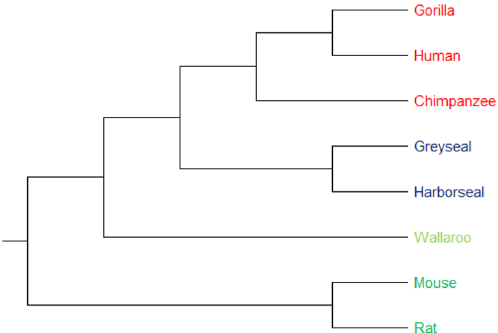
Figure 8. The phylogenetic tree of 8 sequences of NADH Dehydrogenase 6 protein constructed by our method